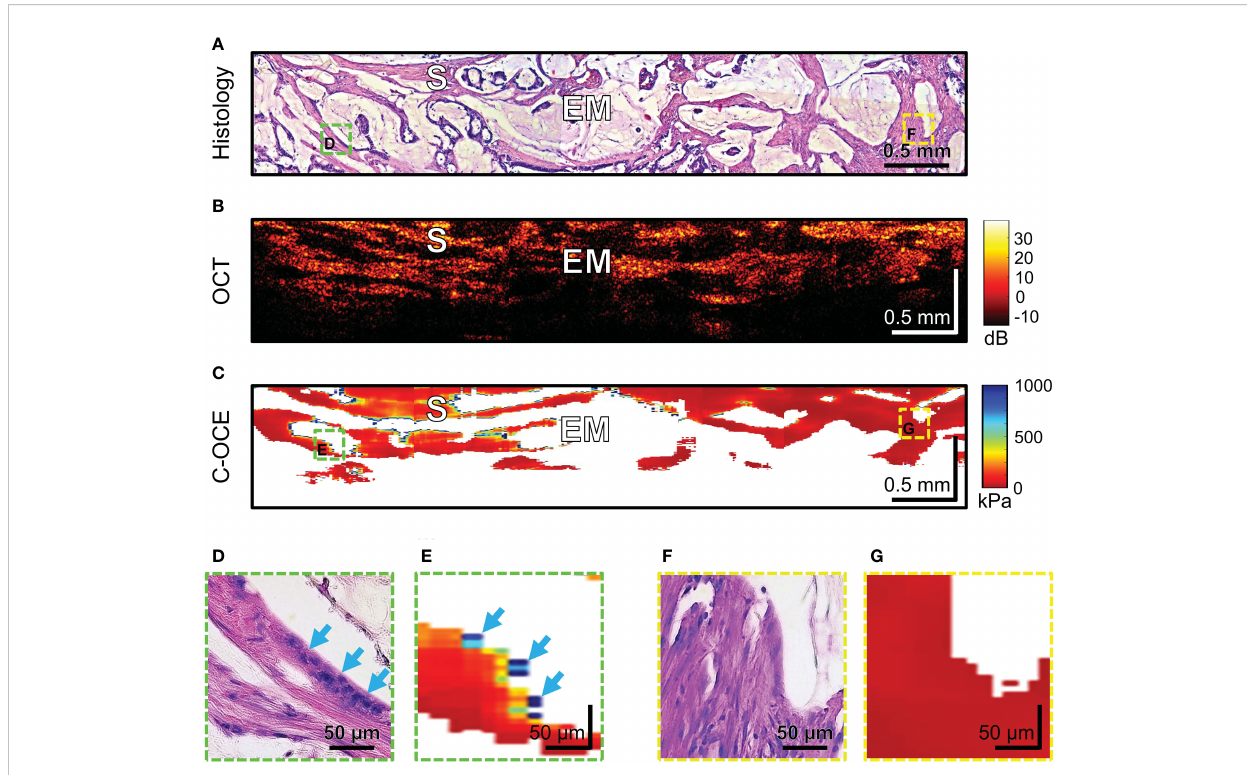
FIGURE 9 Example of morphological examination of mucinous adenocarcinoma (MAC) tissues by C-OCE: abundant accumulations of extracellular mucin [EM] with absence of measured stiffness (non-signal areas) are clearly separated from tumorous stroma [S] having stiffness values around 295 ± 120 kPa. Corresponding tissue areas in histological (A) , OCT (B) and C-O С E (C) images. Enlarged areas (D-G) of tumor tissue in histological (D, F) and C-O С E (E, G) images demonstrate presence (D, E) or absence (F, G) of small clusters of cancer cells, including signet ring cells (blue arrows) attached to stromal fi bers. Bar size is shown in the